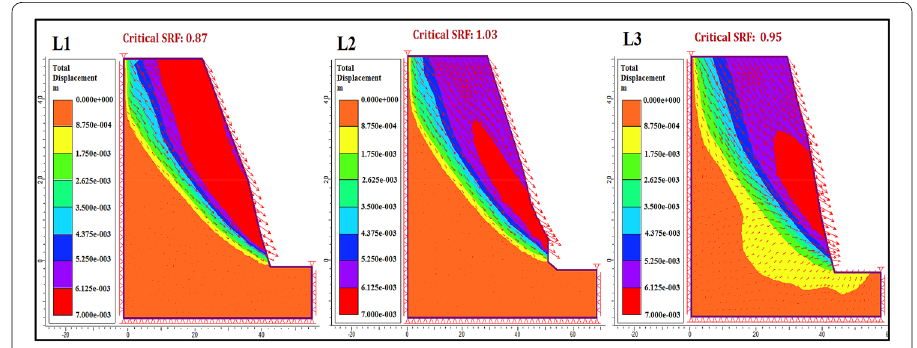
Fig. 7 Indicate the total displacement contour pattern generated from FE results to assess the possible extent of zone of failure